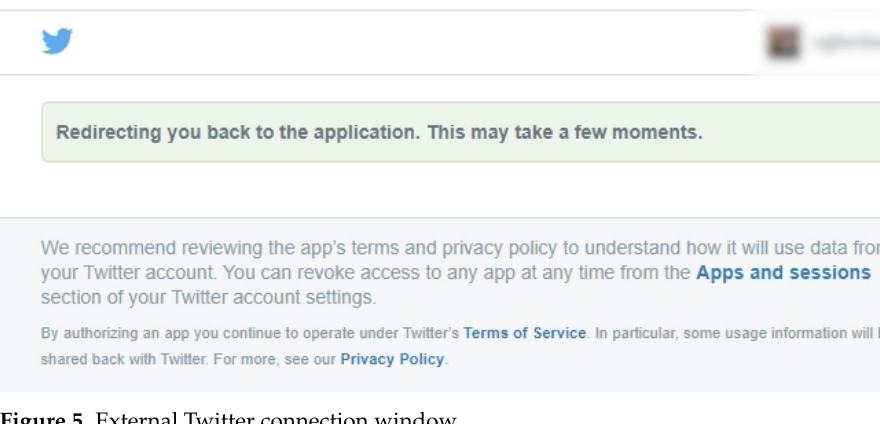
Figure 5. External Twitter connection window.